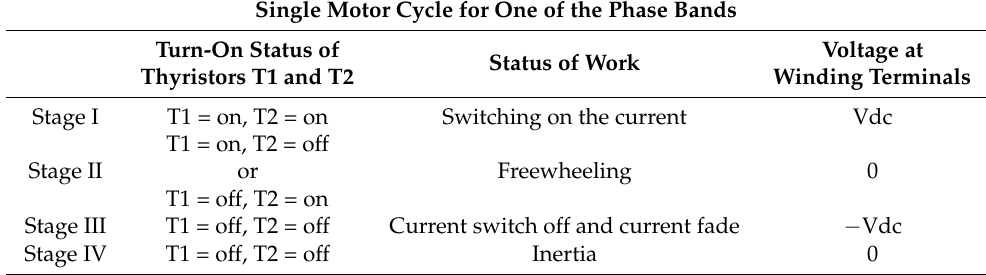
Table 1. A single motor cycle for single-phase band with description.